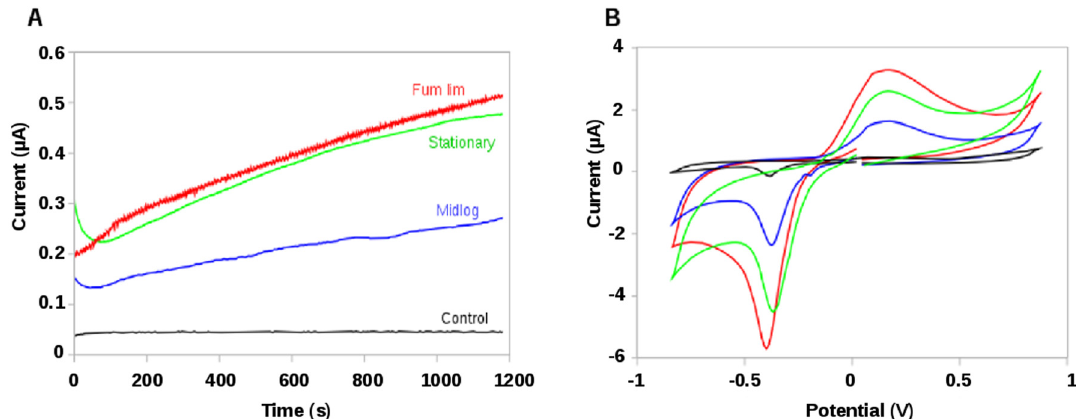
Figure 2. ( A ) Current production by G. sulfurreducens cells under different growth conditions: chemostat cells under fumarate ‐ limiting conditions ( red ), early stationary cells ( green ), midlog cells ( blue ) and buffer control ( black ), polarized a 0.2 V; ( B ) Cyclic voltammetry (CV) of G. sulfurreducens cells under different growth conditions: chemostat cells under fumarate ‐ limiting conditions ( red ), early stationary cells ( green ), mid ‐ log cells ( blue ) and buffer control ( black ).